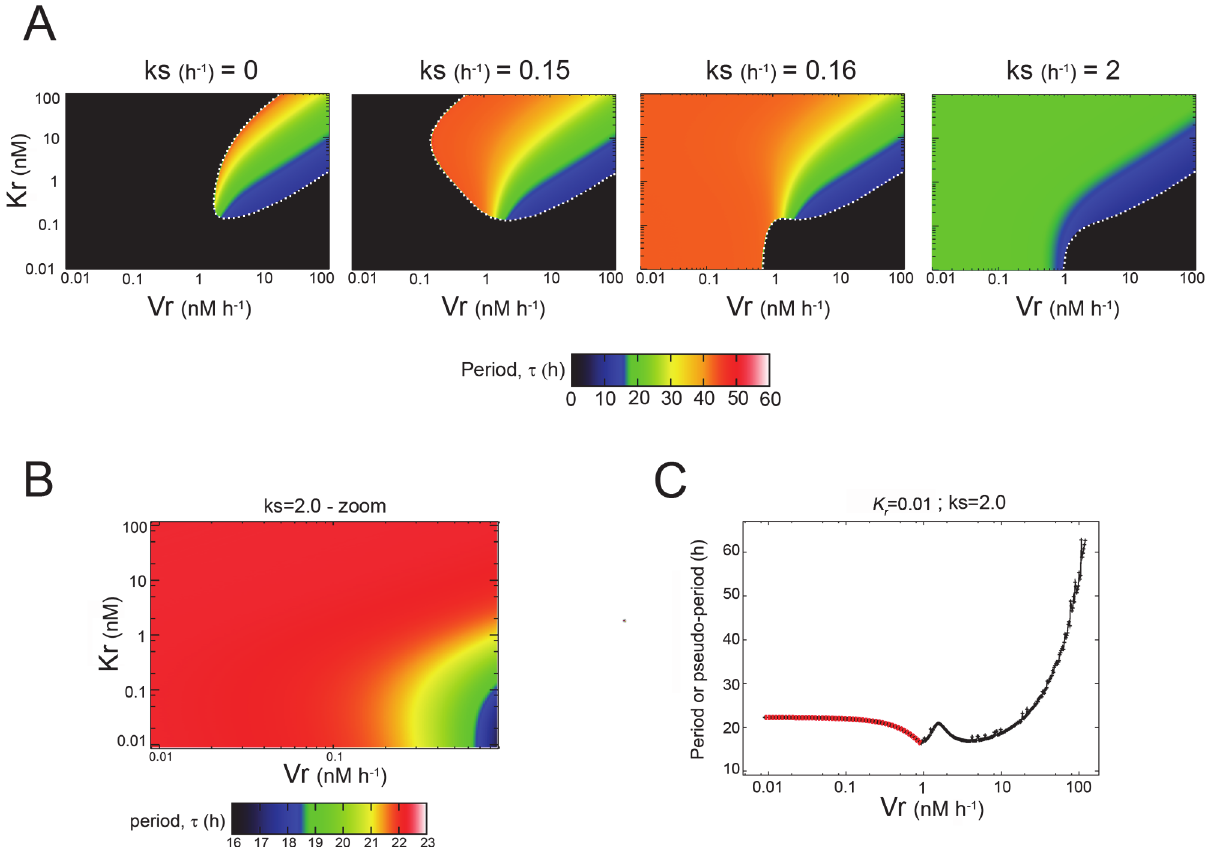
Figure 3. Dependence of the period ( τ ) with k s , V r and K r , for nH = 4. ( A ) The τ values are shown in pseudocolor within the K r - V r -parameter space for different values of the k s parameter from 0 ( left ) to 2 h − 1 ( right ). Black areas indicate zones in which there are damped oscillations. A white dotted line was added in order to emphasize the transition between the two dynamical behaviors observed in our model. Note the changes in the oscillatory domain and the τ length with k s (the color key for τ is at the bottom of the plots). ( B ) An inset of the K r - V r -space shown in panel A for k s = 2 h − 1 ( right ) shows the subtle changes in τ . Note that the key color was rescaled in order to display the differences in more detail. ( C ) Dependence of τ ( red line ) with V r for a fixed value of K r = 0.01 nM ). Black line shows the pseudo-period value for damped oscillations. See the text for further